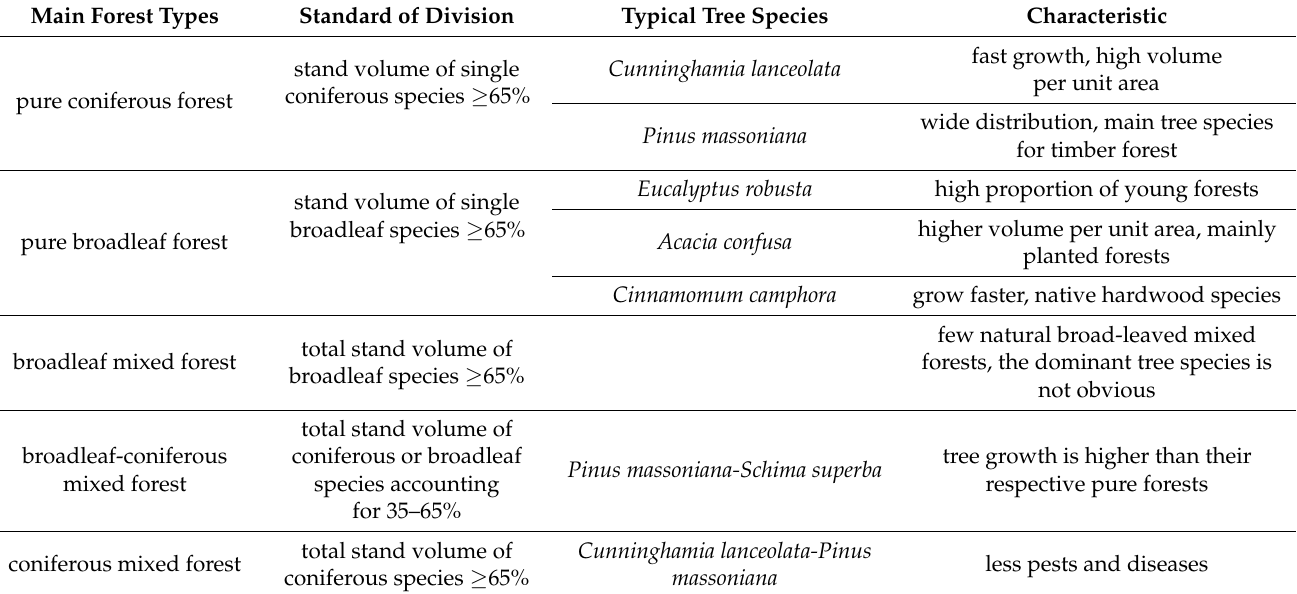
Table 1. Forest types in Shaoguan